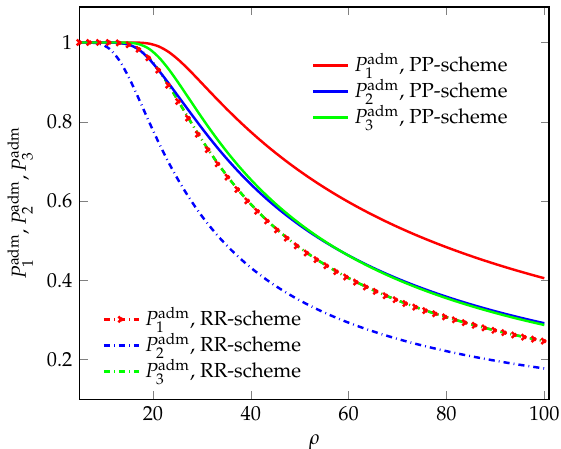
Figure 6. The admission probabilities for arriving requests vs. the offered